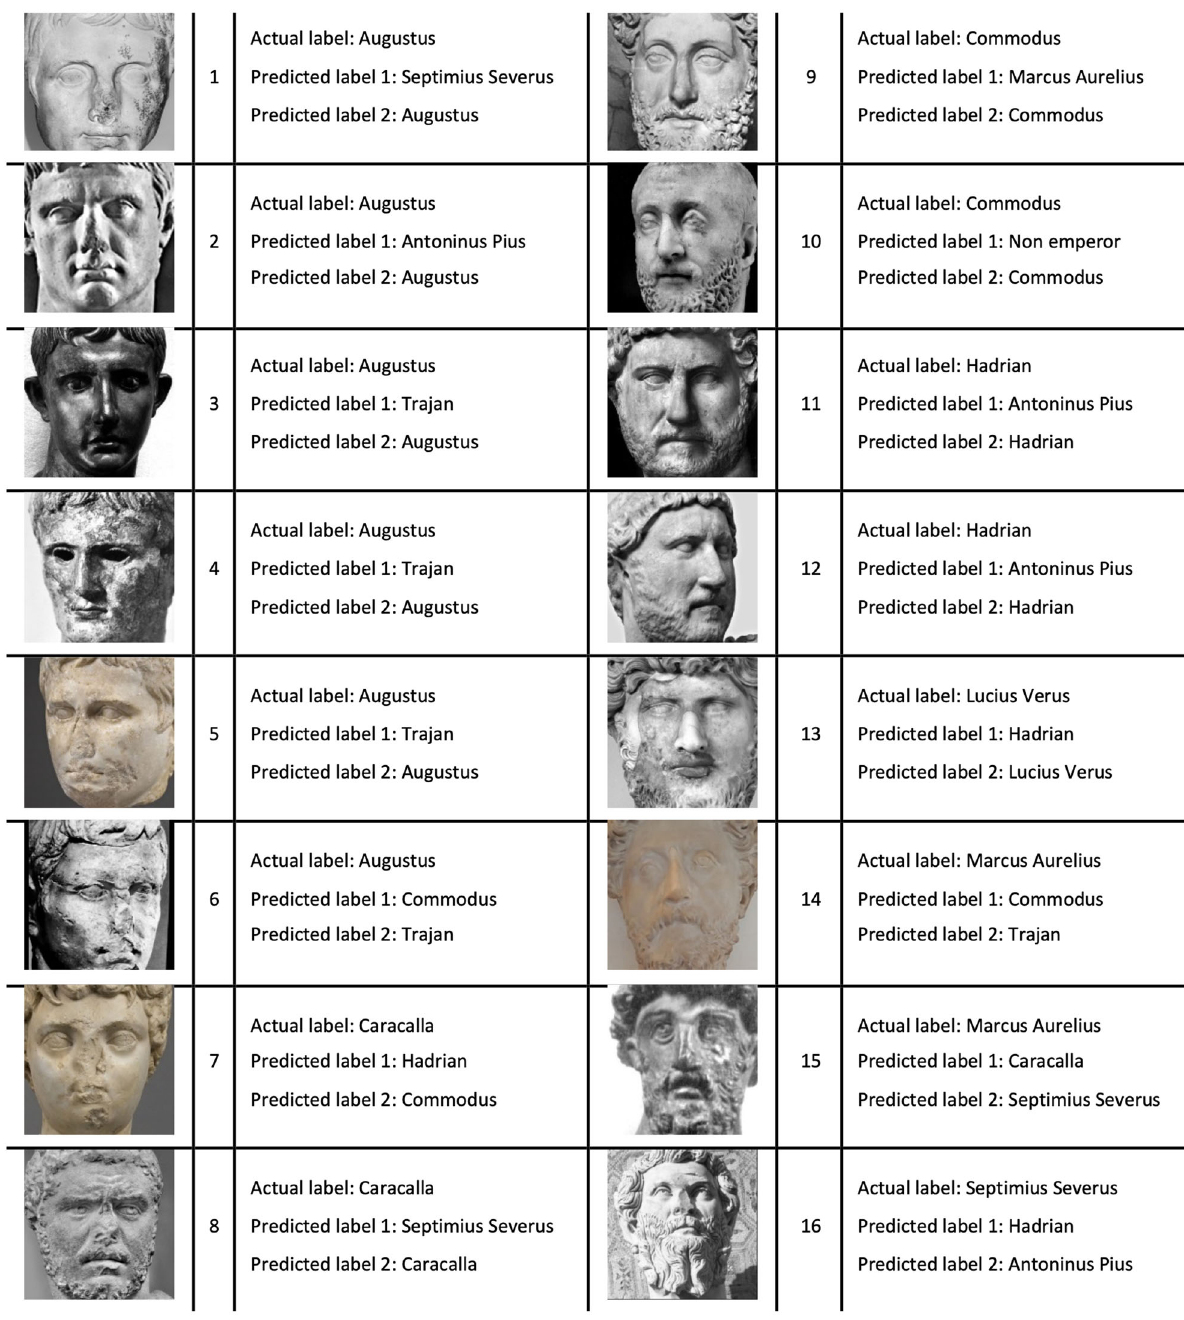
Fig. 10 Misclassi fi cations experiment 2: test set. Images nos 1 – 13, 15 – 16 by the Arachne object database (licensed under CC license BY-NC-ND 3.0) and no. 14 authors ’